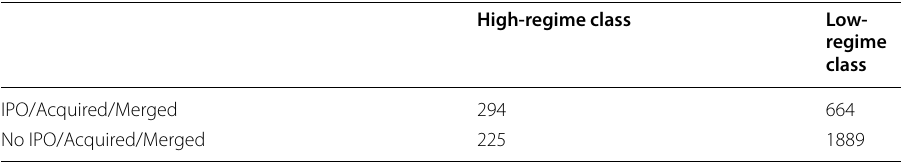
Table 2 Confusion matrix for standard vs trajectory-based binary definition. Accuracy: 0.71; recall: 0.31; precision: